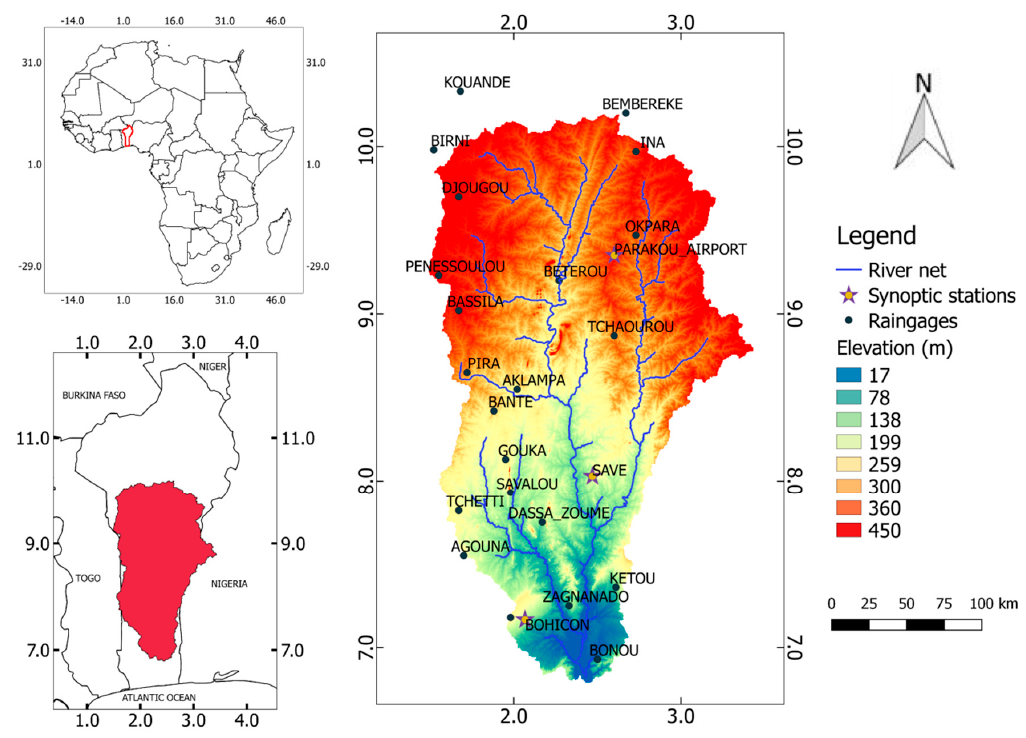
Figure 1. Geographical position of Ouémé catchment.